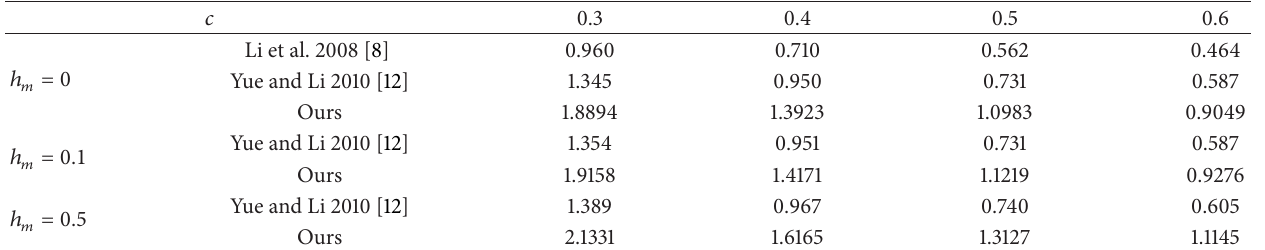
Table 1: Comparison of the maximum value ℎ 𝑀 for the asymptotic stability of system (65) by different methods. 𝑐 0.3